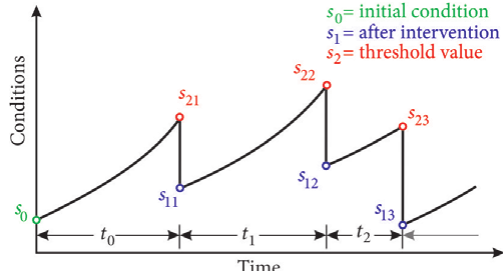
Fig. 2. Pavement condition is assessed determining IRI (Cirilovic et al.